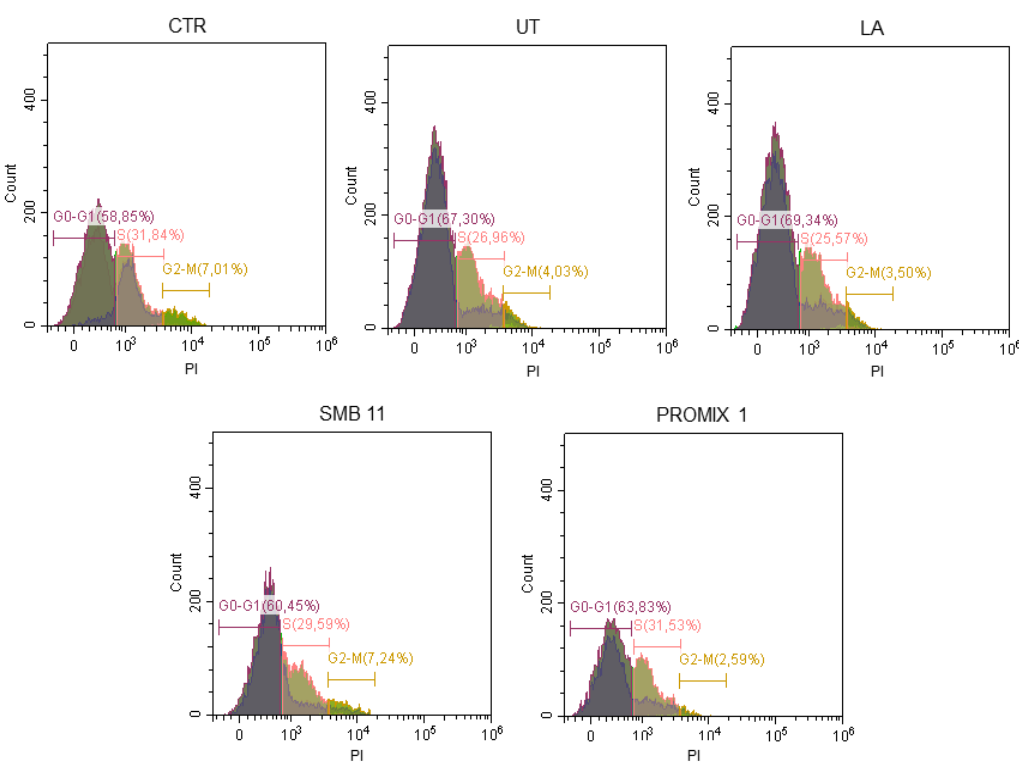
Figure 5. MTT cytotoxicity tests on Namalwa cells treated with 200 µg of seaweed water extracts for 24 h. Results are compared to untreated cells (CTR) and cells lysed with 0.1% Triton X-100 (CTR+). Representative measurements of three distinct sets of data. Data were submitted to one-way analy- sis of variance (ANOVA), Tukey’s post hoc method was applied to establish significant differences among samples ( p < 0.05).